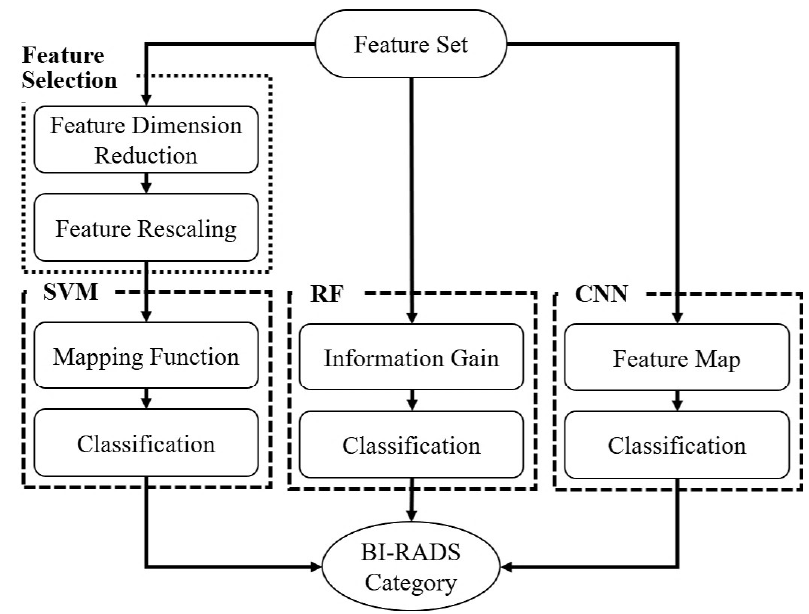
Figure 8. The overview of the process of feature selection and